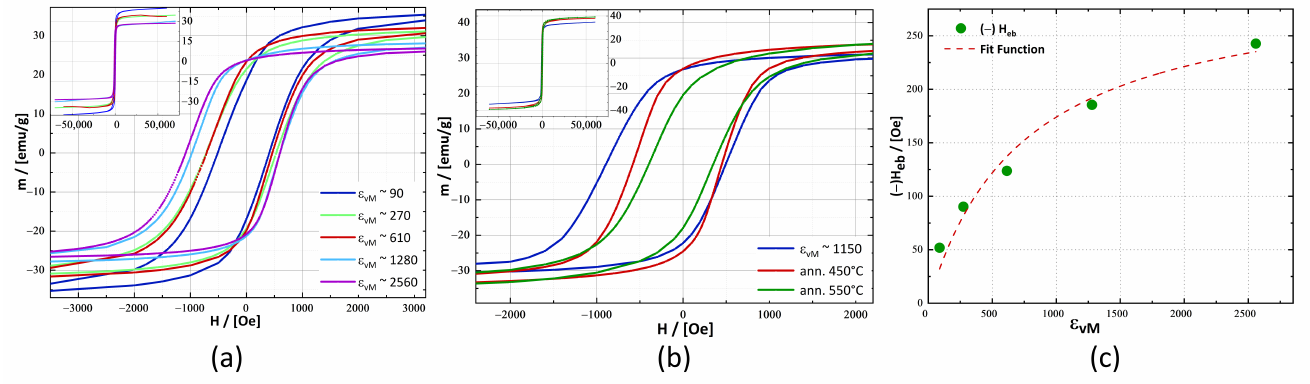
Figure 6. The magnetic hysteresis loops of the Fe 10 Ni 40 NiO 50 sample were measured at 8 K. The graph displays a zoom-in at ± 2000 Oe. The inlet in the left corner provides the whole hysteresis loop. ( a ) Hysteresis loop of as-deformed samples ( b ) Hysteresis loops of the annealed samples. ( c ) H eb for different amounts of applied strain. The used fit is not based on a physical model and serves only to approximate the expected saturation of H eb for an infinite amount of applied strain.